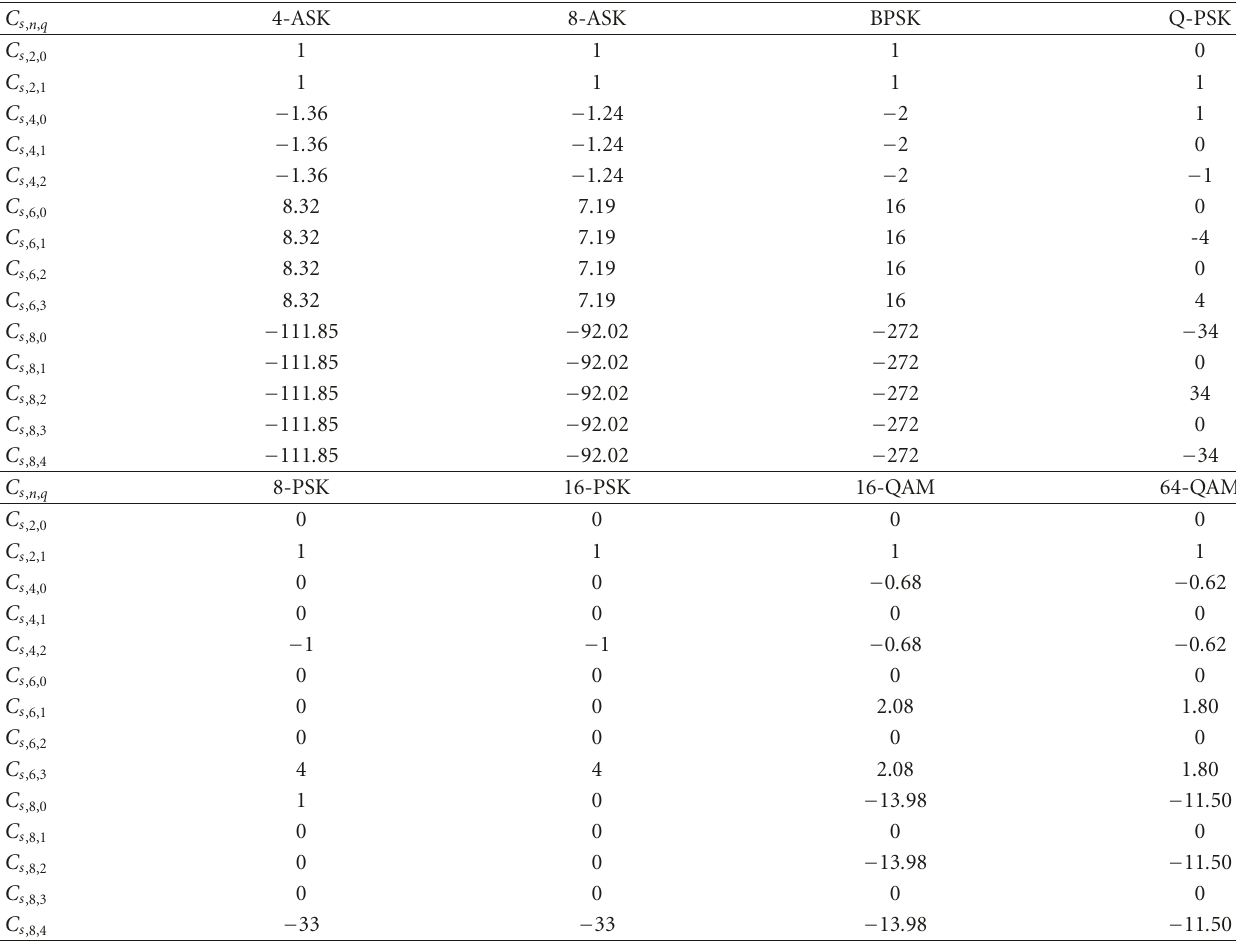
Table 1: Theoretical stationary cumulants